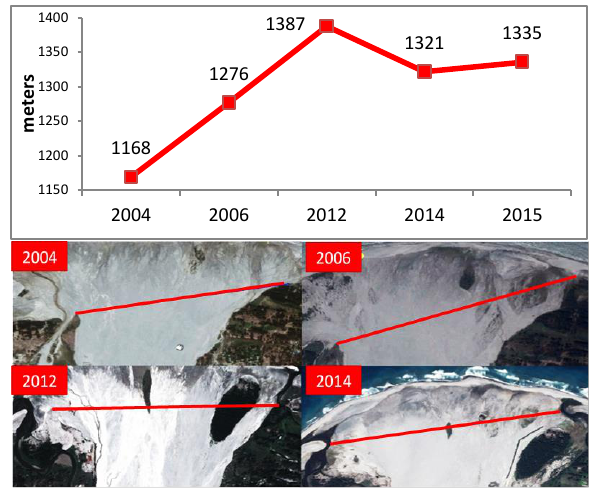
Figure 6. Santo Tomas River Outlet captured using Google Earth